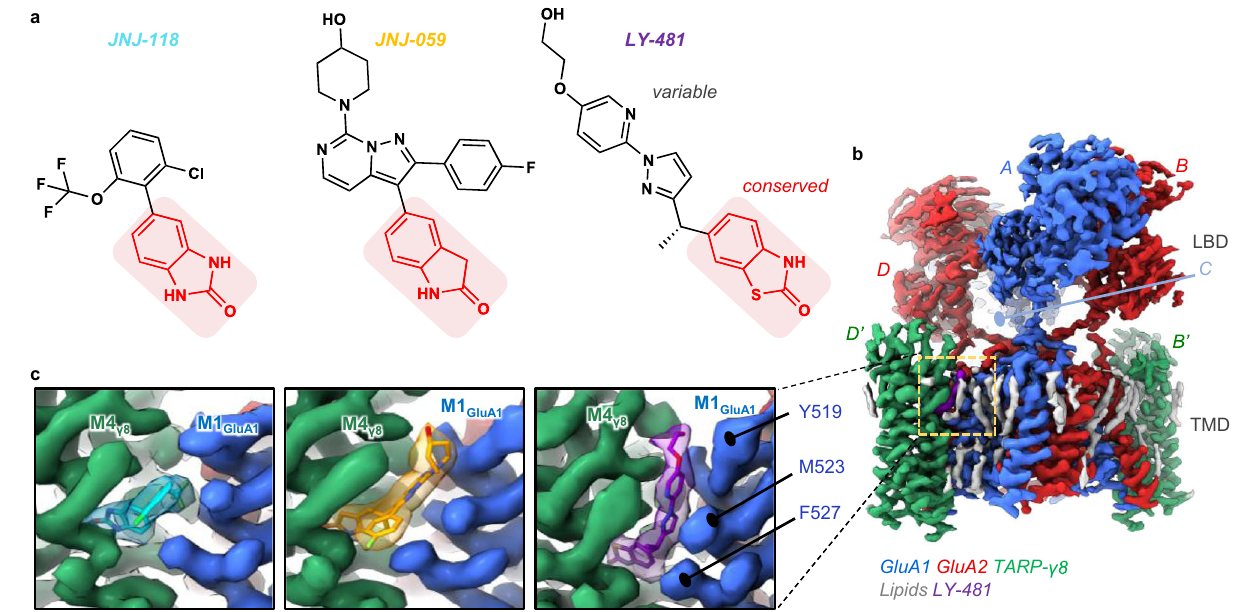
Fig. 1 | Cryo-EM maps of three NAMs bound to the resting-state GluA1/2_ γ 8 AMPAR. a Chemical structures of the three NAMs. The shared oxindole isostere is labelled red, the variable groups are shown in black. b Cryo-EM map of the GluA1/ 2_ γ 8 LBD (Ligand Binding Domain) and TMD (Transmembrane Domain) sectors, associated with LY-481. The colour code of protein, lipid and NAM is indicated